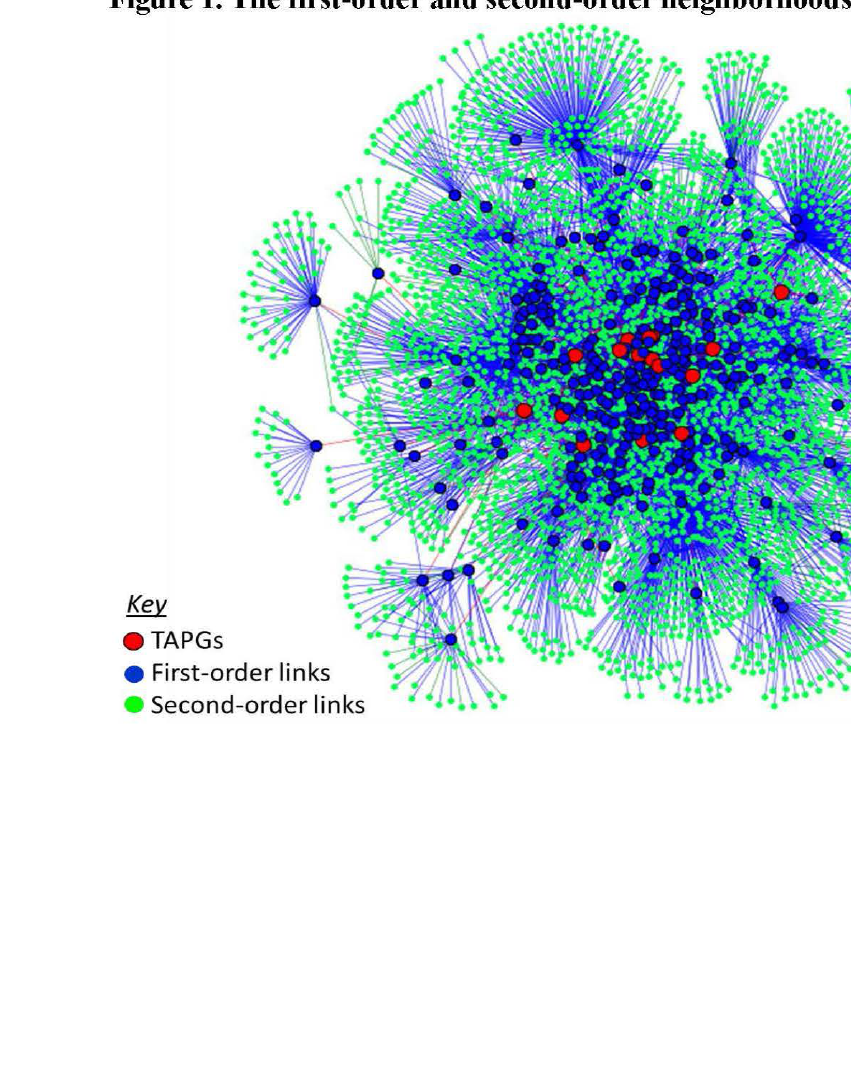
Figure 1. The first-order and second-order neighborhoods of